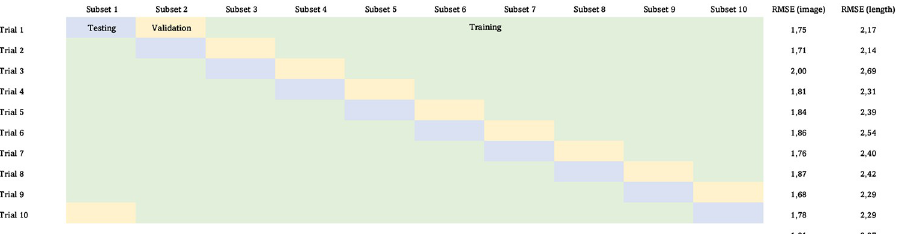
Fig 7. Cross-validation test results. Individual test results for all cross-validation trials for both the image based deep learning age estimates, and the linear length based age estimates.